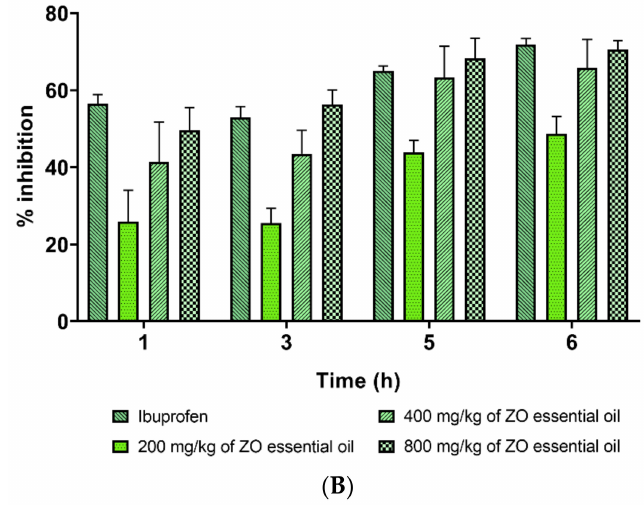
Figure 3. Effects of ZO essential oil and ibuprofen on carrageenan-induced hind paw edema in rats. ( A ) Mean changes in paw edema volume and ( B ) the percentages of paw edema inhibition after pretreating with ZO essential oil (200, 400, and 800 mg/kg) and ibuprofen (100 mg/kg) at different time points. Data represent the mean ± SEM ( n = 6). * Denotes significant differences ( p < 0.05) compared to the control